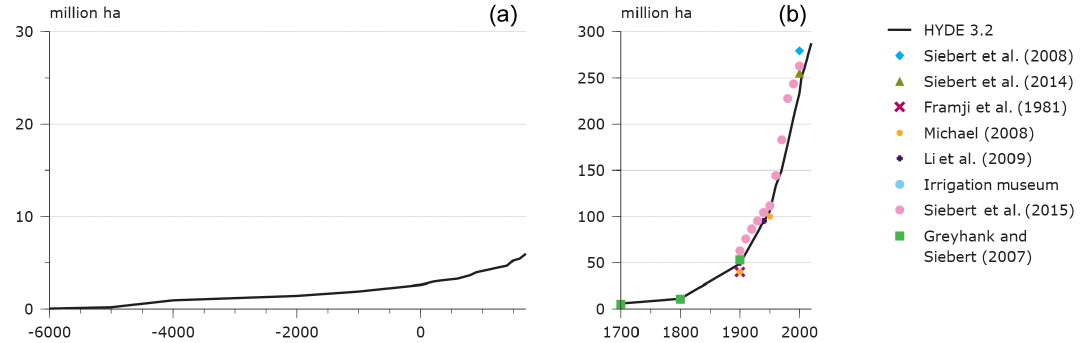
Figure 5. Historical (actual) irrigated area estimates for two periods: 6000BCE–1700CE (a) and 1700–2010CE (b)